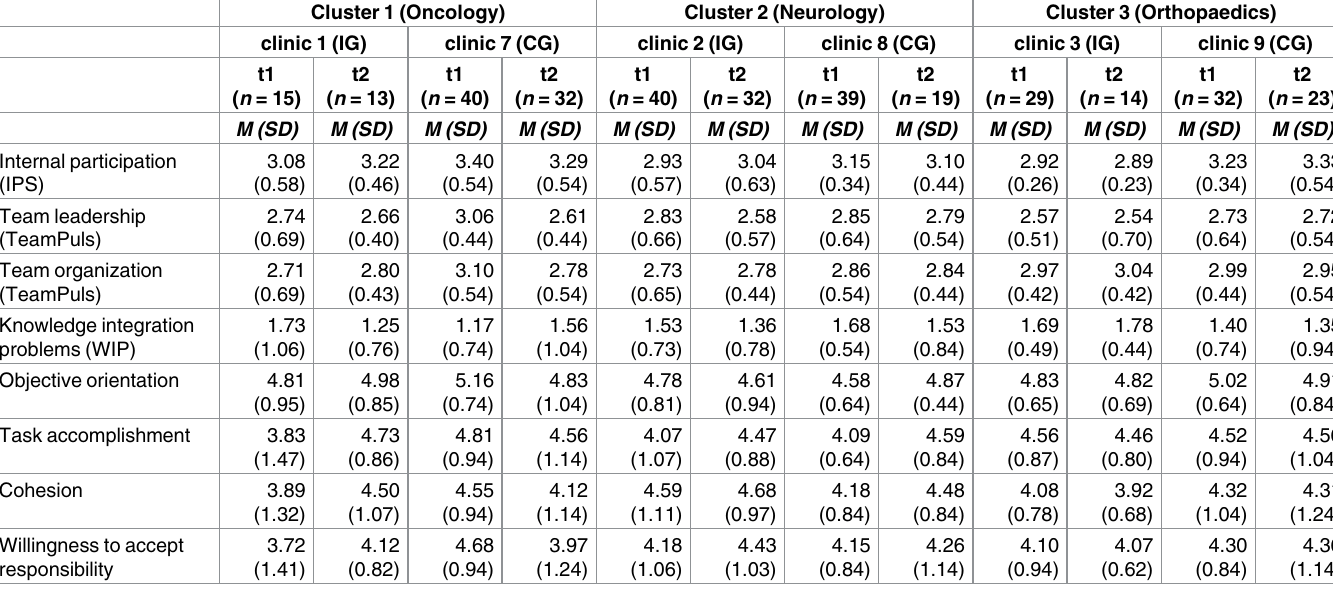
Table 5. Clinic specific means of outcome criteria of the staff survey (Cluster 1 to 3).